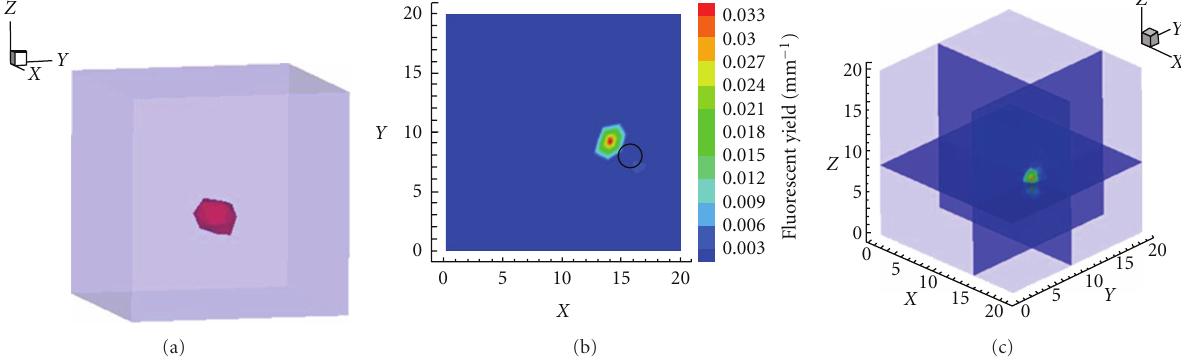
Figure 7: Reconstructed results of cubic phantom by our method. (a) is the isosurface view of the result. (b) is the corresponding transverse view at z = 8 . 5 mm where the black circle represents the actual source. (c) is the perpendicular cross section of the reconstruction result.